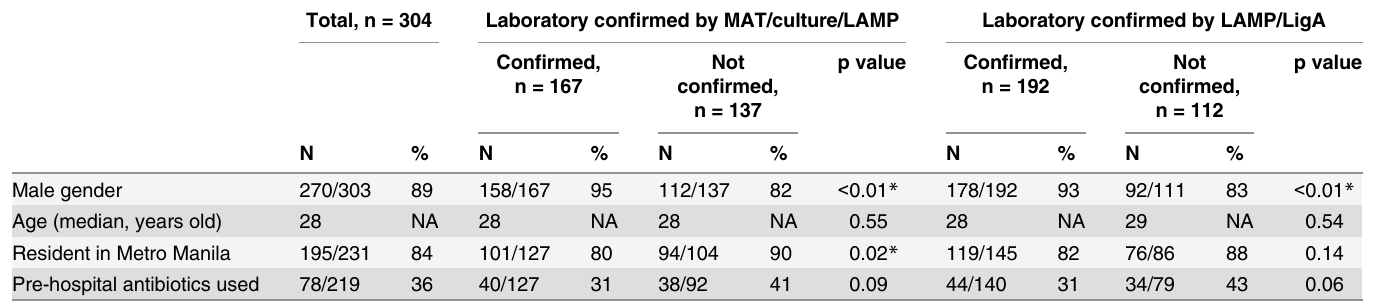
Table 1. Demographic characteristics of enrolled cases by laboratory confirmation